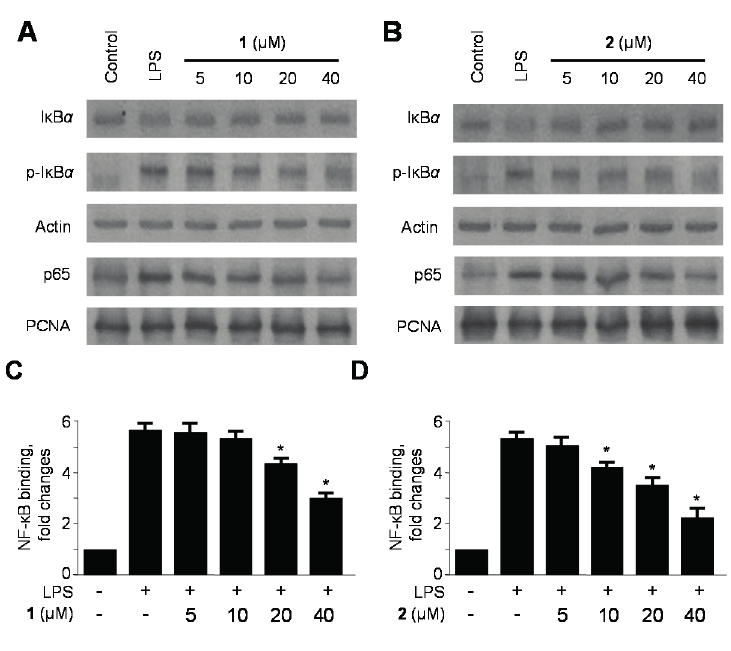
Figure 6. Effects of compounds 1 and 2 on nuclear factor- κ B (NF- κ B) activation ( A , B